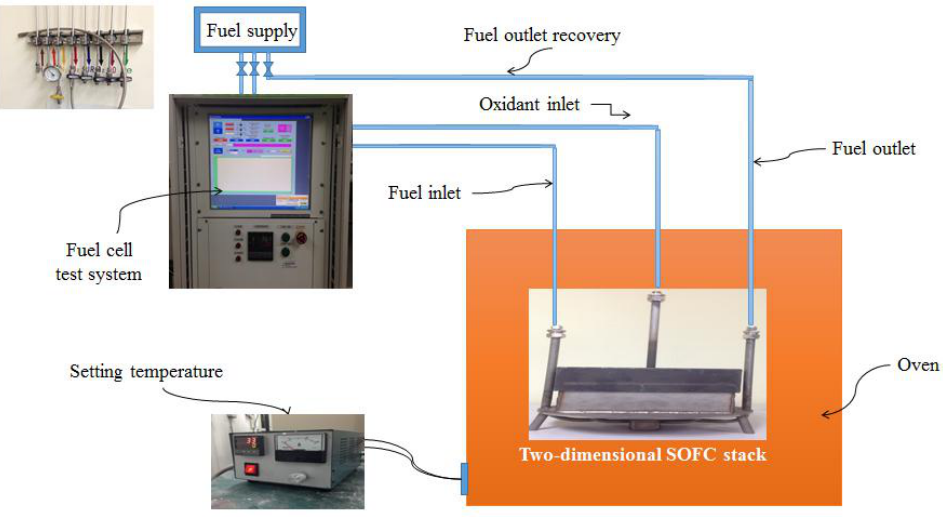
Figure 6. Schematic of the SOFC stack testing system.